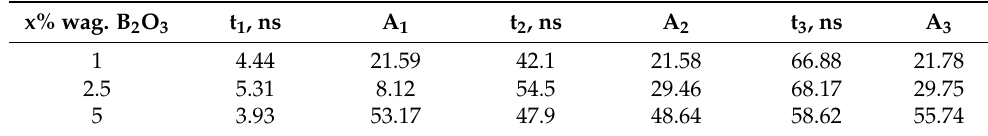
Figure 6. PL decay kinetics at RT recorded at 570 nm under blue light excitation (450 nm) in MPs sintered with different amounts of B 2 O 3 flux ( a ) and different concentrations of Ce 3+ ions ( b ). Table 2. Parameters of three exponential approximations of the decay curves presented in Figure 6a (Em = 570 nm, Ex = 450 nm).